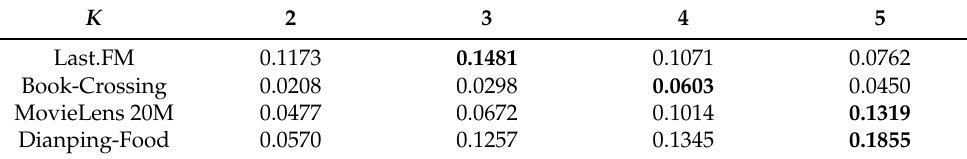
Table 4. The Recall@10 results in terms of the number of neighboring entities K